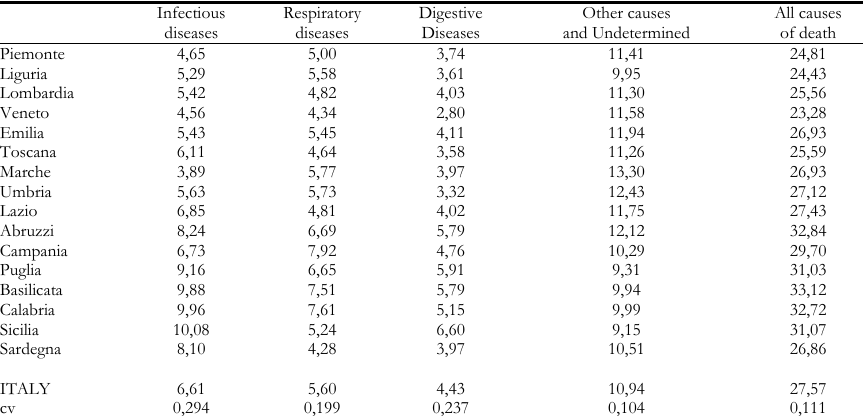
Death rates (p. 1000) by cause groups (both sexes) in Italian regions, 1888 Infectious Respiratory Digestive Other causes All causes diseases diseases Diseases and Undetermined of death Piemonte 4,65 24,81 Liguria